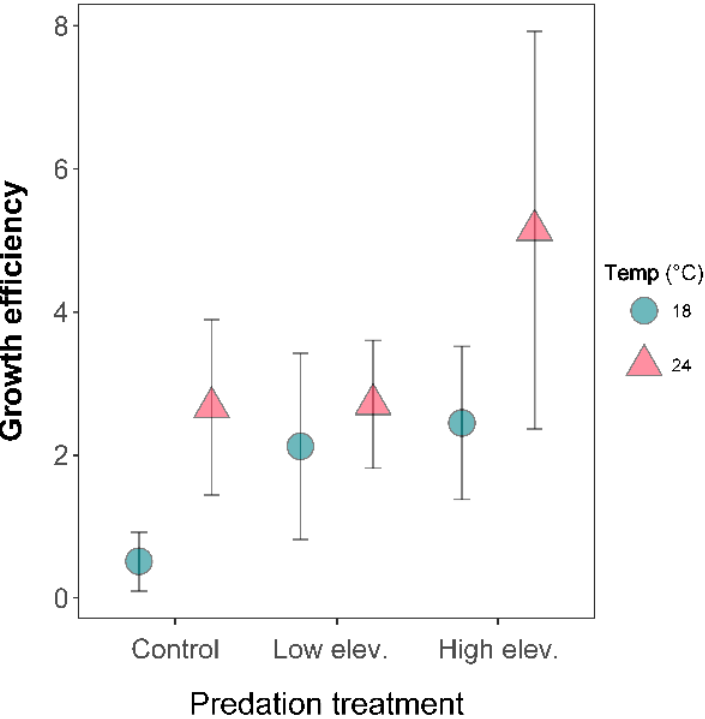
Figure 3. Growth efficiency of Sympetrum striolatum larvae in the combination of two temperature and three predator treatments. Error bars are 95% confidence intervals.